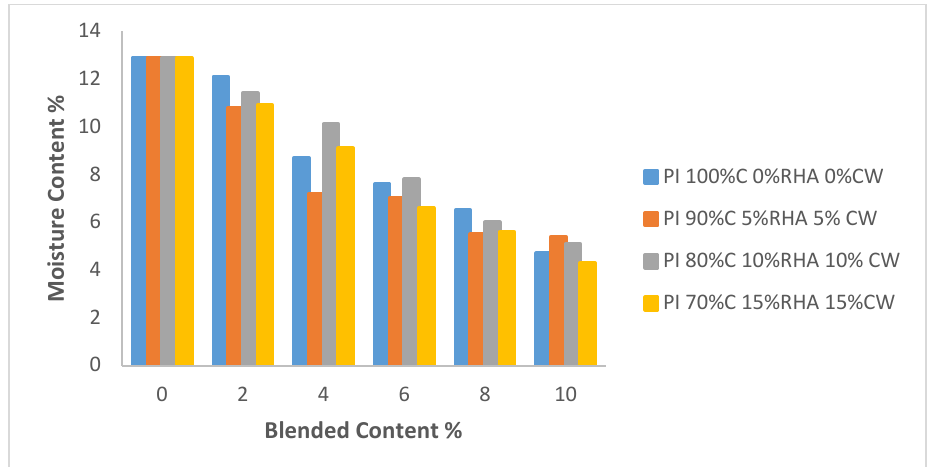
Fig. 4. Relationship between the PI of laterite treated with (100%C 0%RHA 0%CW), ( 90%C 5%RHA